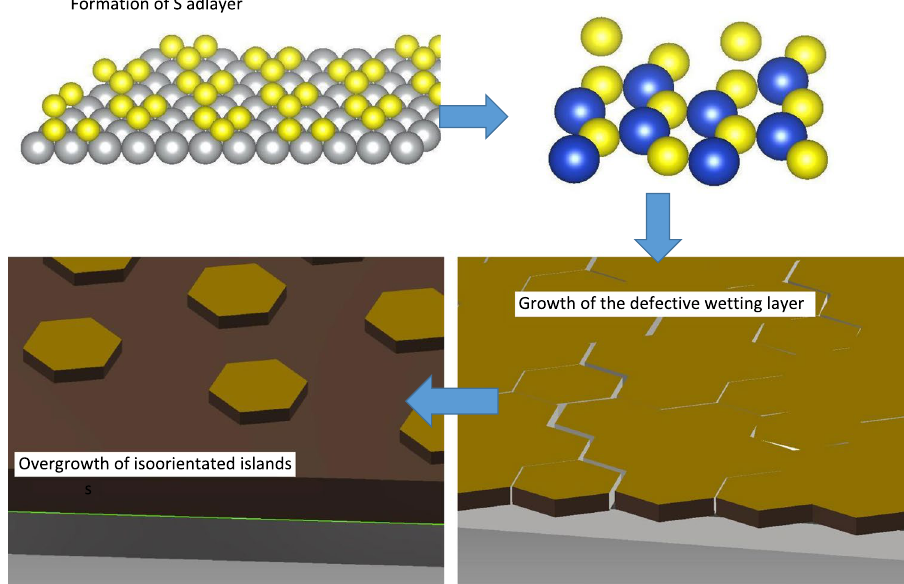
Figure 8. Pictorial representation of the proposed mechanism for the E-ALD growth of Cu 2